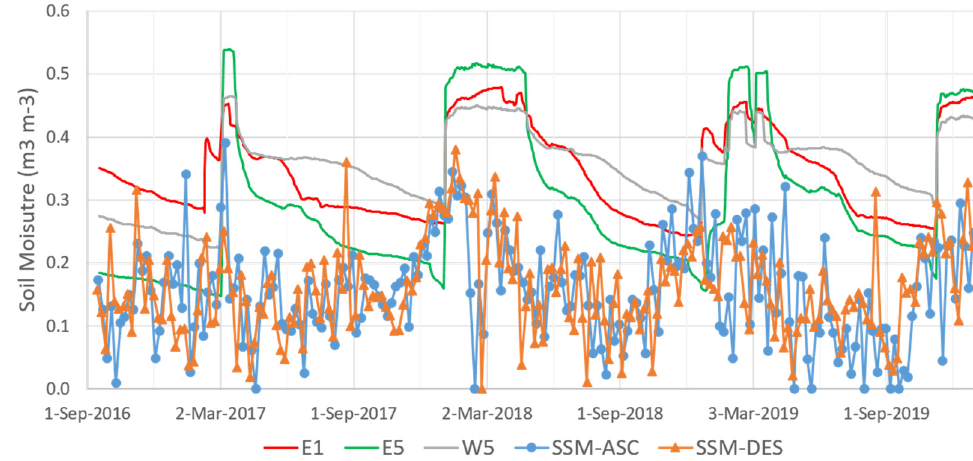
Figure 5. Comparison of three soil moistures at about 1.2 m depth (E1, E5, W5) to the Surface Soil Moisture SSM-ASC and SSM-DES using the SMOS ascending and descending track, respectively.